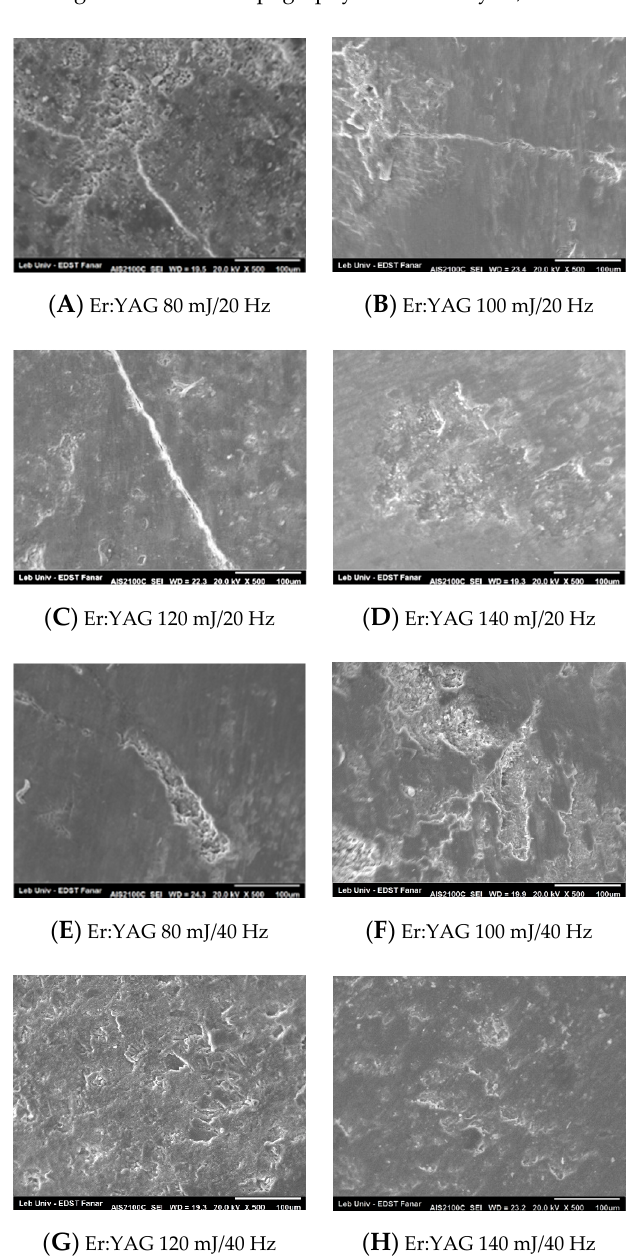
Figure 9. SEM figures of enamel topography debonded by Er:YAG subgroups.